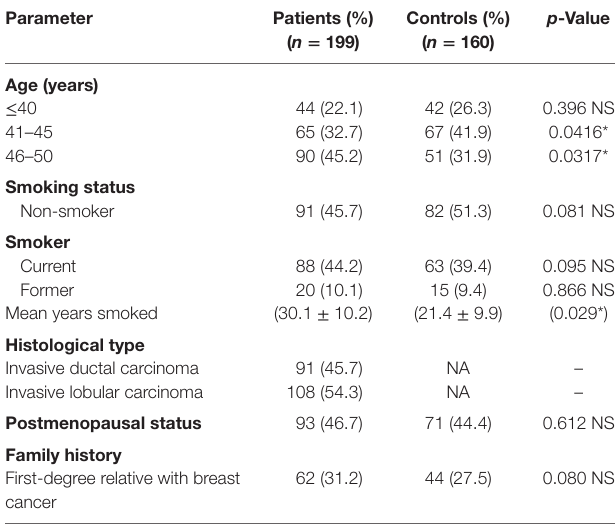
TaBle 1 | Demographic characteristics of women with breast cancer (patients) and healthy